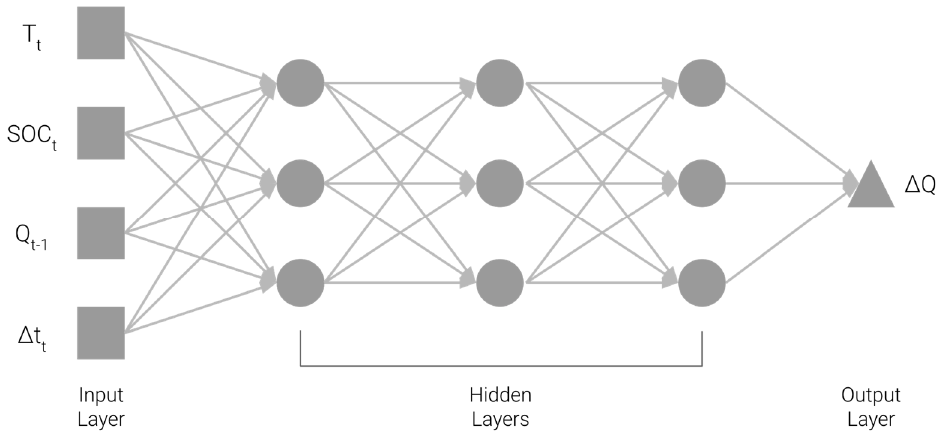
Figure 3. Designed NN model.